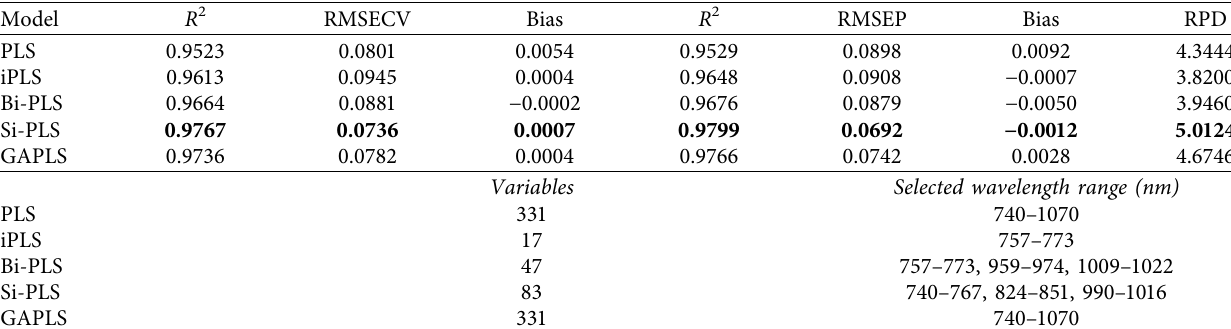
Figure 7: Si-PLS spectra selection: (a) and model plots (b) for NIR estimation and measured value. Table 5: Optimum performance of diferent quantifcation models for fertilizer B.